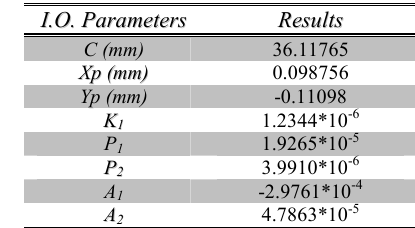
Table 2. Interior orientation parameters